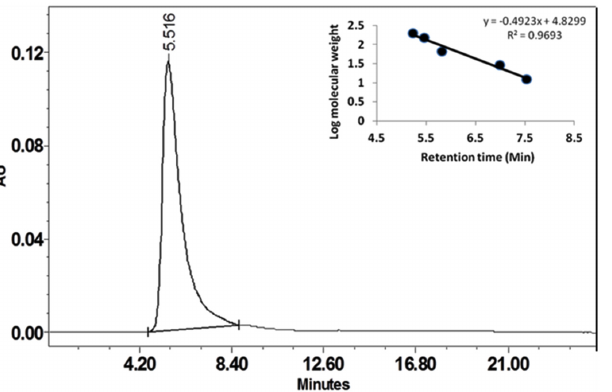
Fig 3. Elution profile of cupincin on analytical gel filtration column. Assessment of the molecular mass of cupincin. x-axis- retention time in minutes, y-axis- Absorbance unit (Au) @ 280 η m. The column was calibrated with 1) U -Globulin, 2) Bovine serum albumin, 3) Carbonic anhydrase, 4) Cytochrome C and 5) Aprotinin. The column was equilibrated with 0.1 M sodium phosphate buffer pH 7.0 and the proteins were eluted at a flow rate of 1 mL /min. The samples were run for 25 minutes. Retention time of cupincin was determined to be 5.516 minutes corresponding to the mass of around 135 kDa as estimated based on the calibration curve constructed with known molecular mass proteins in the range of 6.5kDa-160 kDa (inset).